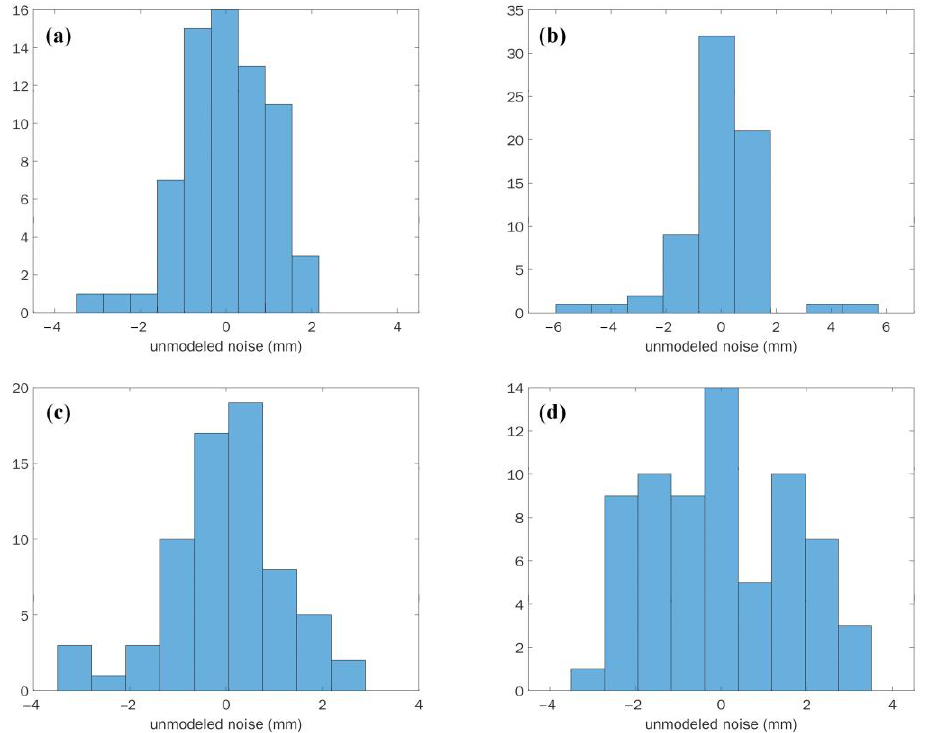
Figure 6. The histograms of the unmodeled noise derived for “P1”, “P2”, “P3”, and “P4” using the time series decomposition method. ( a ) PI in Qianhai sub-area, ( b ) P2 in HKIA sub-area, ( c ) P3 in Wutong Mountain sub-area, ( d ) P3 in Liantang sub-area.